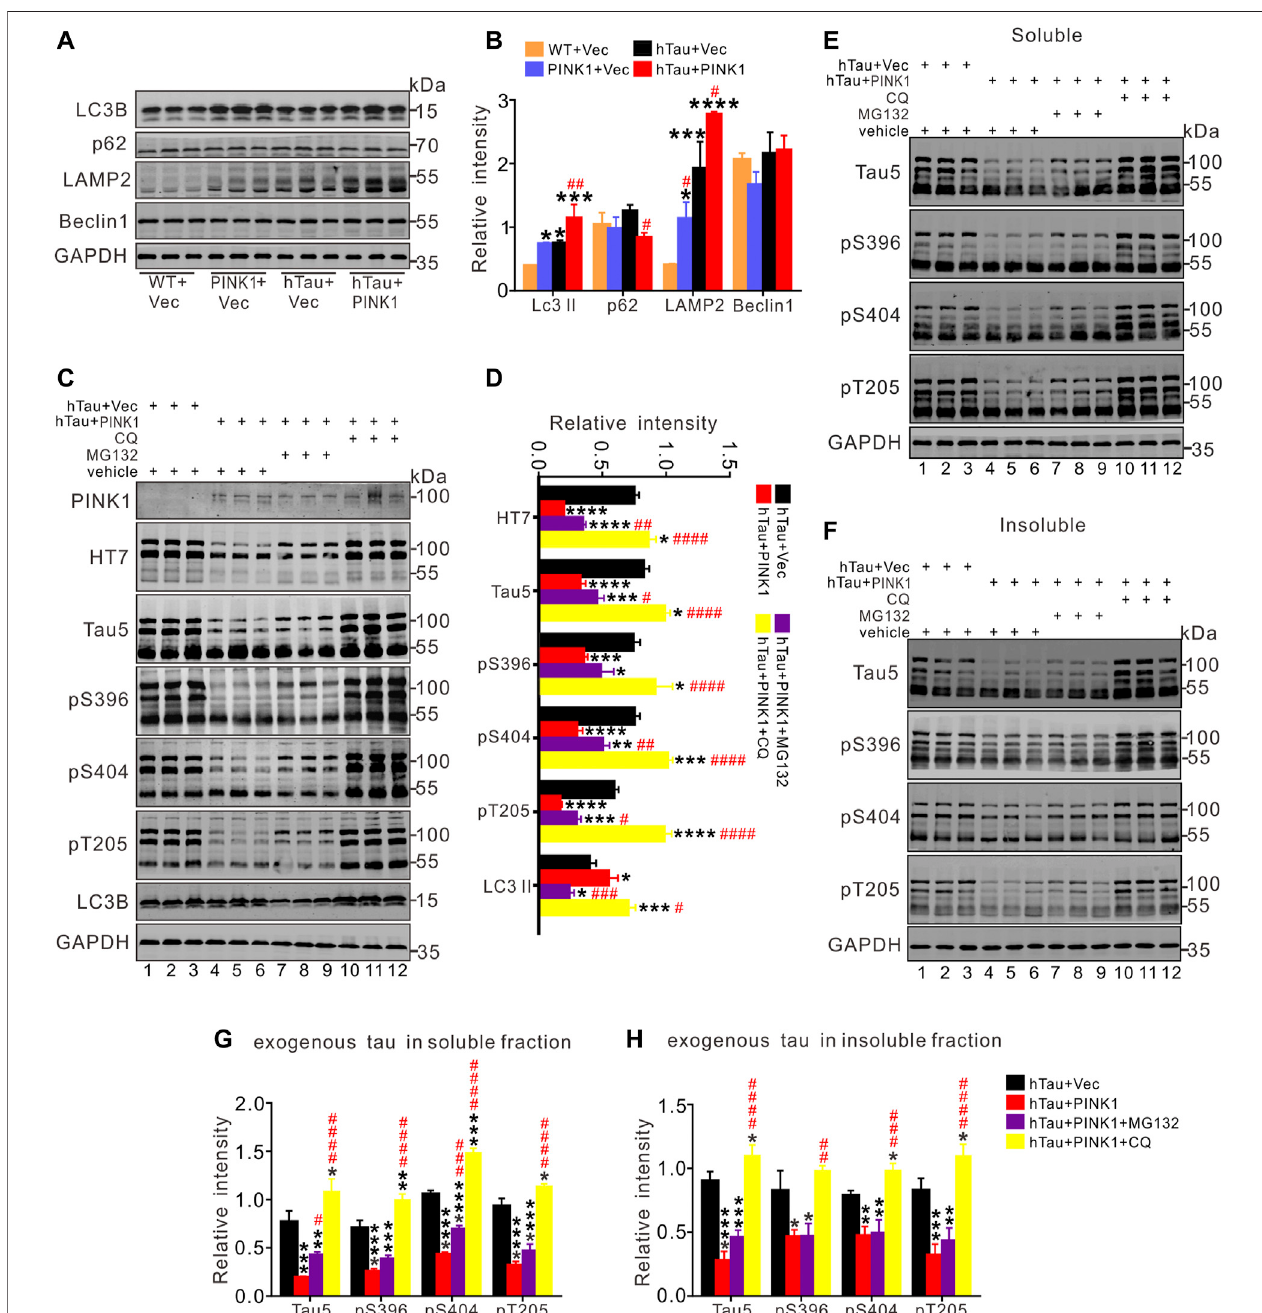
FIGURE 5 | PINK1 promotes clearance of hTau mainly through the autophagy pathway. (A,B) PINK1 increased the levels of LC3 II and lysosomal protein LAMP2 , as well as decreased p62 levels detected by Western blot. One-way ANOVA followed by Tukey multiple-comparisons tests. * p < 0.05, ** p < 0.01, *** p < 0.001, **** p < 0.0001vs. WT +Vec; # p < 0.05, ## p < 0.01 vs. hTau+Vec. (C,D) Intotalfraction ofmice hippocampal CA1,PINK1 diminished thelevelsofexogenoustau( ∼ 106 kDa, human tau: both total and phosphorylatedtau), while CQ treatment reversed this reduction shown by Western blot. Treatment with MG132induced relatively small increase in the levels of hTau proteins in hTau and PINK1 overexpressing mice. (E – H) In both the soluble (E, G) and insoluble fraction (F, H) of mice hippocampal CA1 area, PINK1 decreased the levels of exogenous tau ( ∼ 106 kDa, human tau: both total and phosphorylated tau) in hTau mice, while CQ treatment reversed the reduction. Treatment with MG132 induced relatively small increase in the levels of hTau proteins in the soluble fraction. One-way ANOVA followed by Tukey multiple- comparisonstests.* p < 0.05,** p < 0.01,*** p < 0.001,**** p < 0.0001vs.hTau+Vec; # p < 0.05, ## p < 0.01, ### p < 0.001, #### p < 0.0001vs.hTau+PINK1.Alldatawere presented as mean ± SD. n (cid:2) 3 mice for each